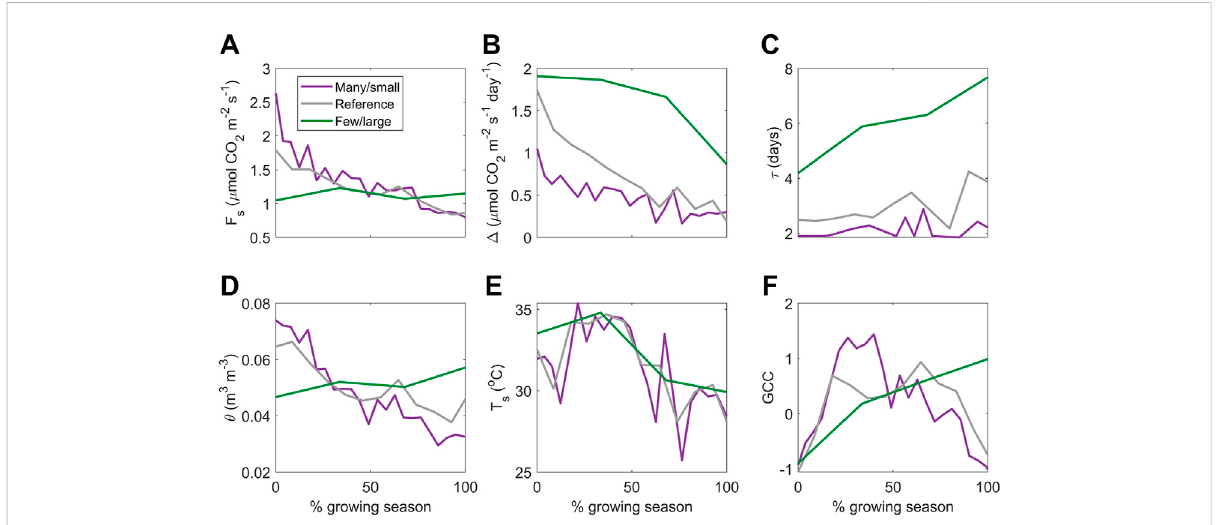
FIGURE 6 Seasonalevolutionofthe (A) averagedailyrate, (B) magnitudeofpulseincrease( Δ )and (C) exponentialtimedecayconstant( τ )ofsoilCO 2 ef fl ux (F s ) during pulse events. Bottom row shows average daily (D) soil moisture ( θ ), (E) soil temperature (T s ), and (F) normalized anomalies of green chromatic coordinate (GCC) during pulse events. Colors denote the three levels of rainfall